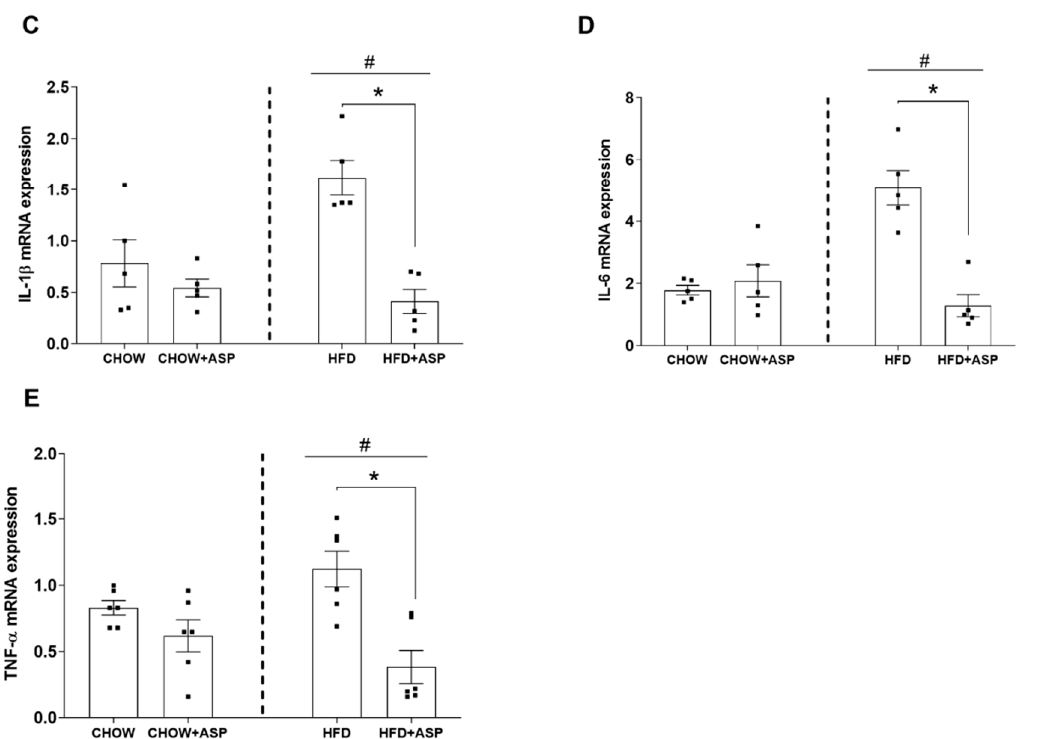
Figure 1. Effect of asperuloside on hypothalamic genes involved in food intake and inflammation: ( A ) Agouti-related peptide (AgRP); ( B ) Neuropeptide Y (NPY); ( C ) Interleukin 1 beta (IL-1 β ); ( D ) Interleukin 6 (IL-6); and ( E ) Tumour necrosis factor-alpha (TNF- α ). n = 6. Standard chow diet (CHOW), high-fat diet (HFD), asperuloside (ASP). Results are expressed as mean ± SEM. Data were analysed by Two-way ANOVA followed by a least significant difference. * Significant ASP effect ( p < 0.05); # Significant overall diet effect [HFD and HFD + ASP] vs. [CHOW and CHOW + ASP] ( p < 0.05).